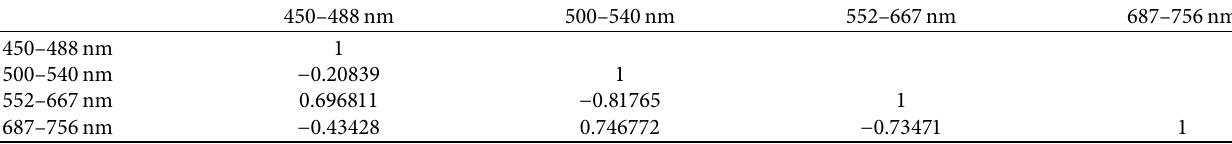
Table 2: Correlation of the first-order differential sum between four wavelength regions.